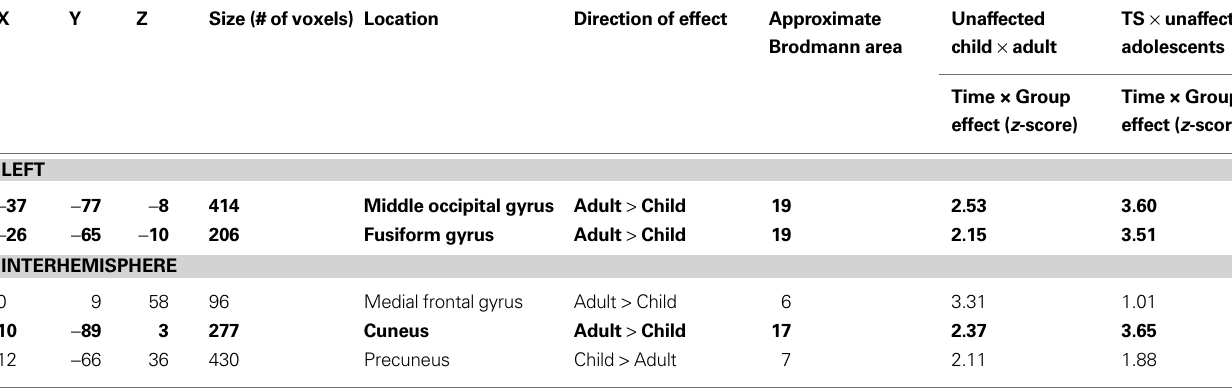
Table 4 | START-CUES: 5 brain regions showing a signifi cant start-cue group effect between typical children and adults for the visual modality of the task (sphericity-corrected p -values <